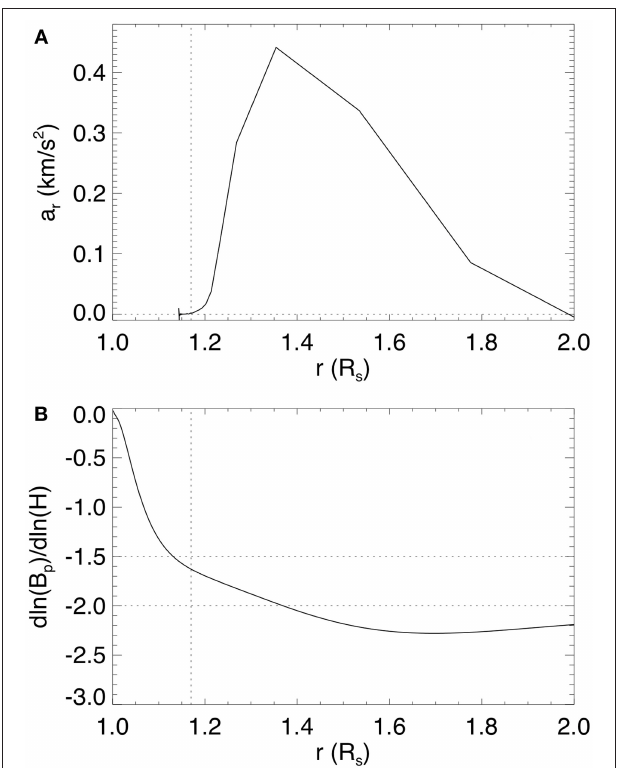
FIGURE 4 | (A) Acceleration at the apex of the flux rope’s axial field line as a function of its height position, and (B) the decay rate of the corresponding potential magnetic field strength B p with height H (above the surface) when the emergence is stopped (after which the lower boundary normal magnetic flux distribution and the corresponding potential field remain fixed).